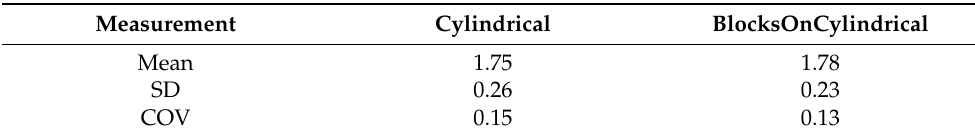
Table 2. Mean, standard deviation (SD), and coefficient of variation (COV) of the measured uni- form cylinder.